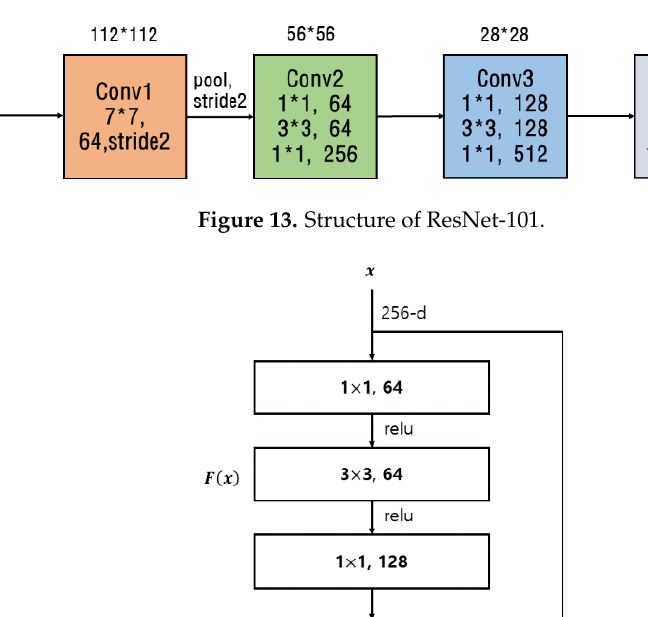
Figure 13. Structure of ResNet-101.